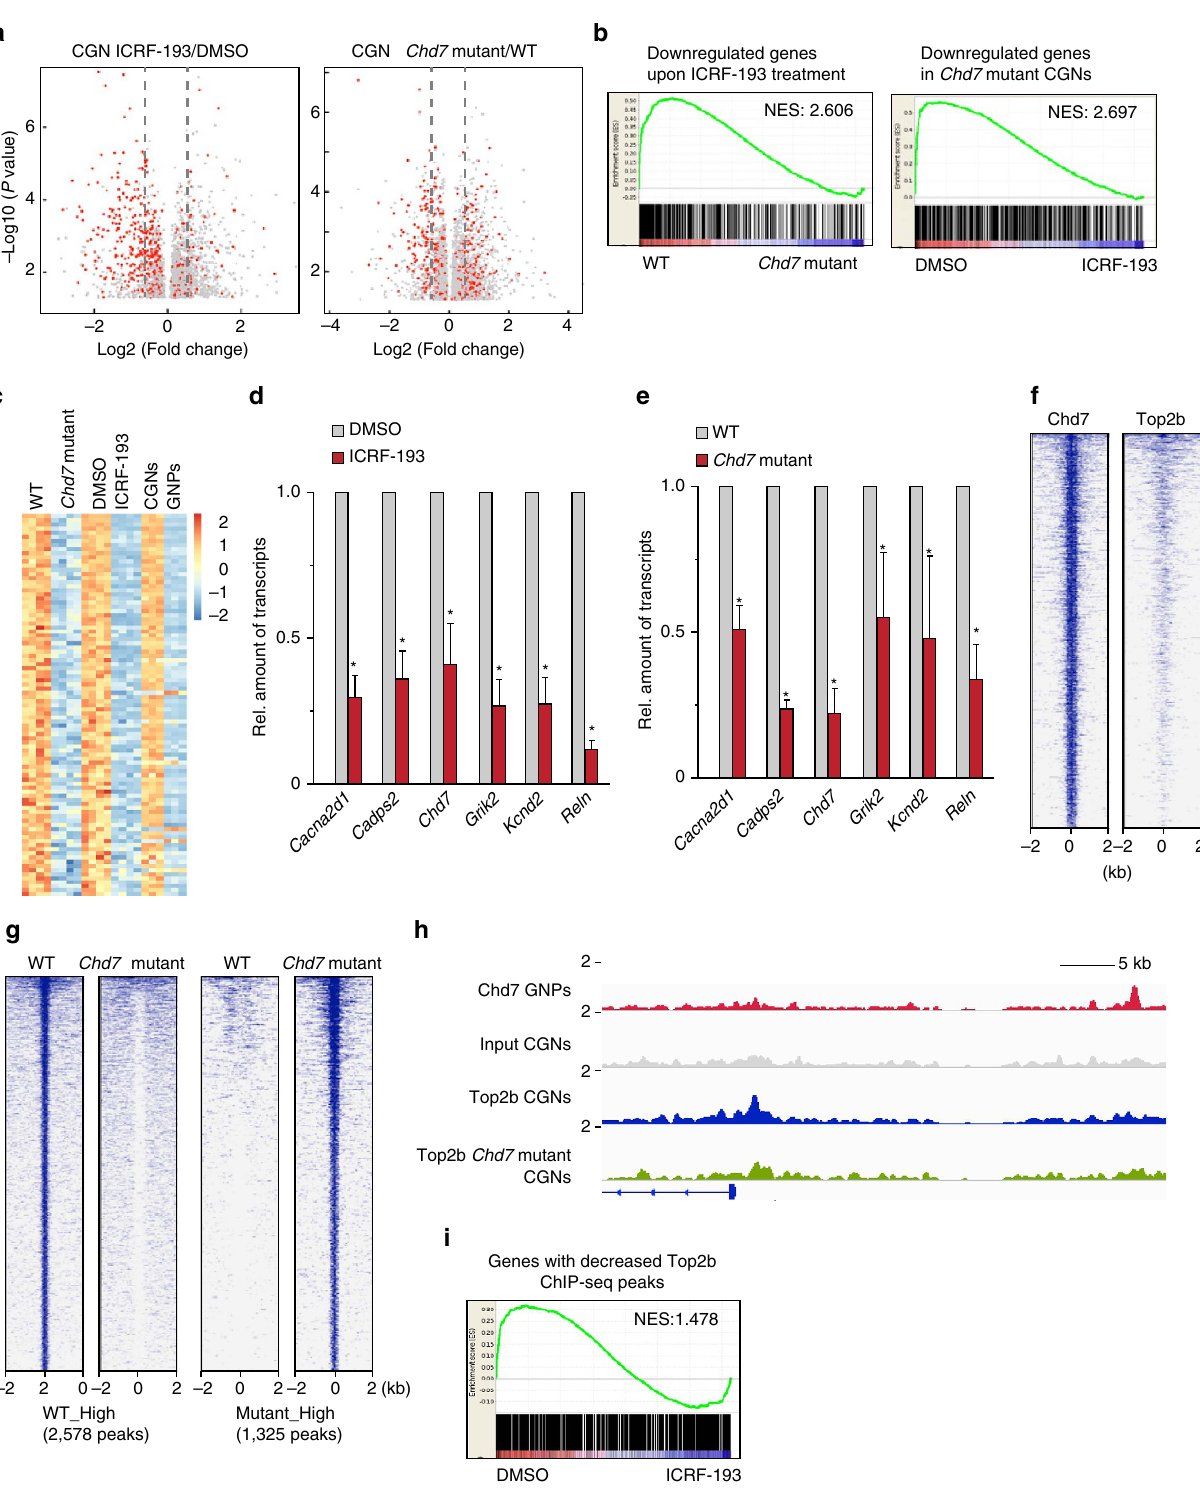
that expression of a subset of neuronal genes are regulated by Chd7 and